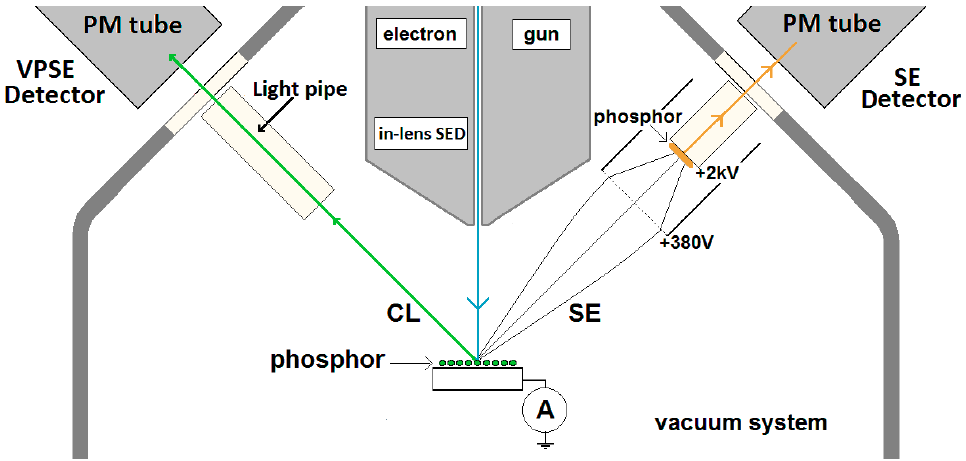
shown in Figure 9b excited at 200 keV and room temperature in the TEM.